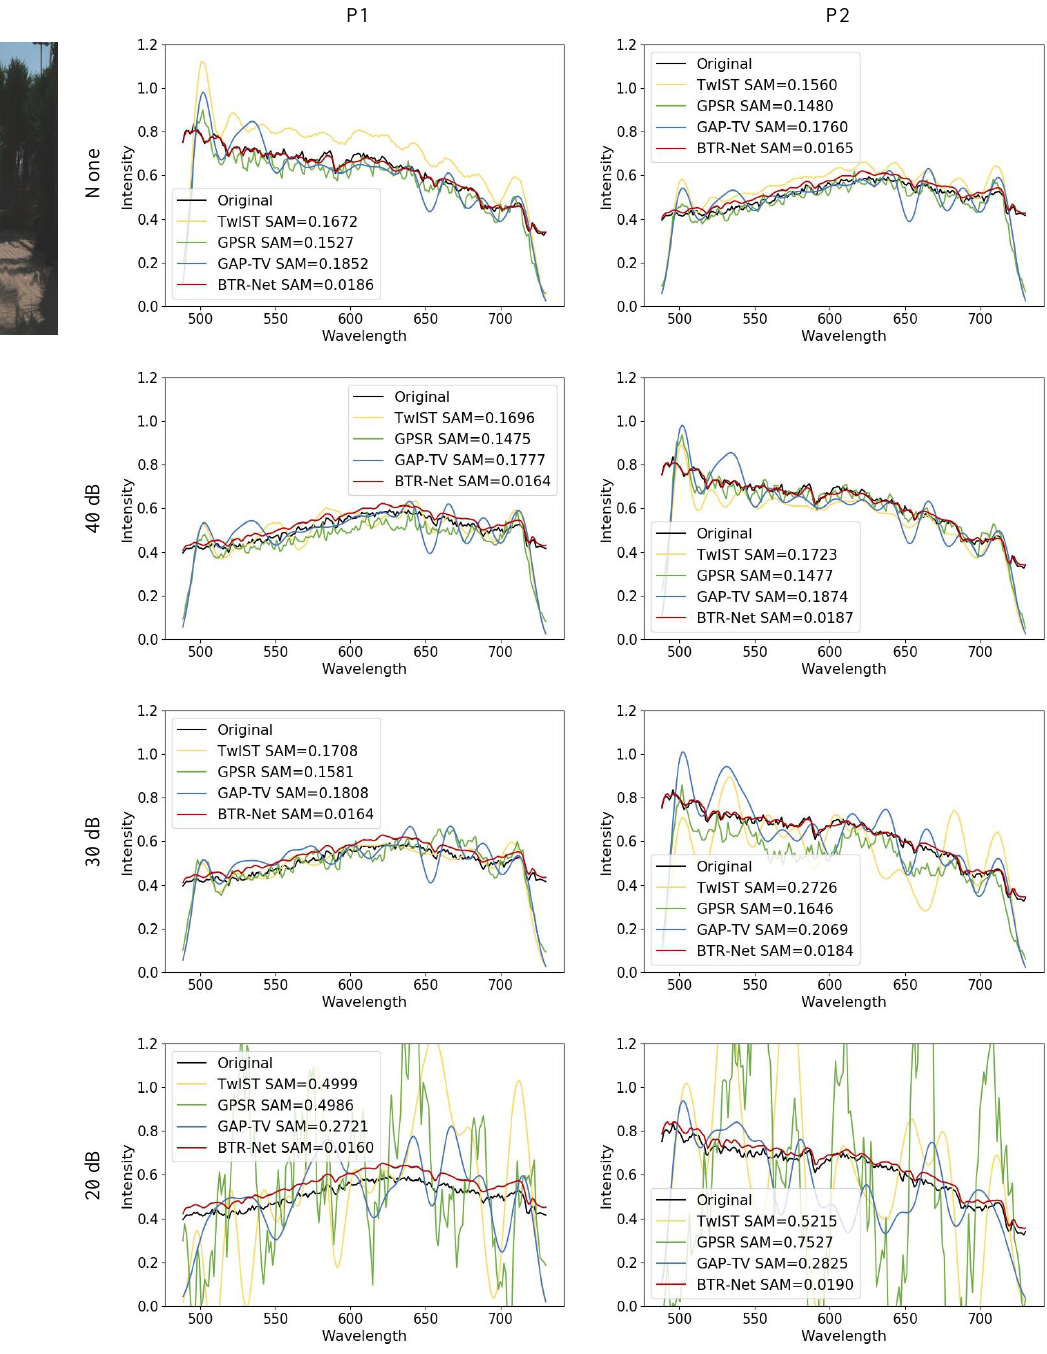
Figure 8. Comparisons of the reconstructed spectra at different noise